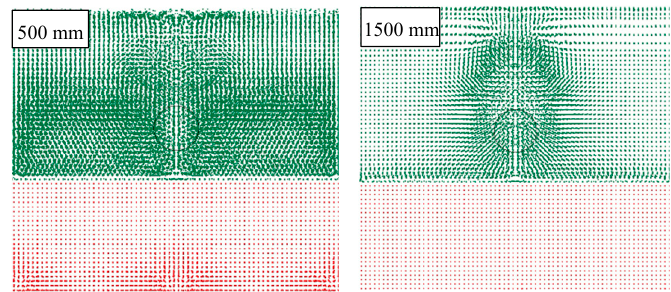
Figure 13. Effect of different falling heights on the air particles (500 and 1500 mm).